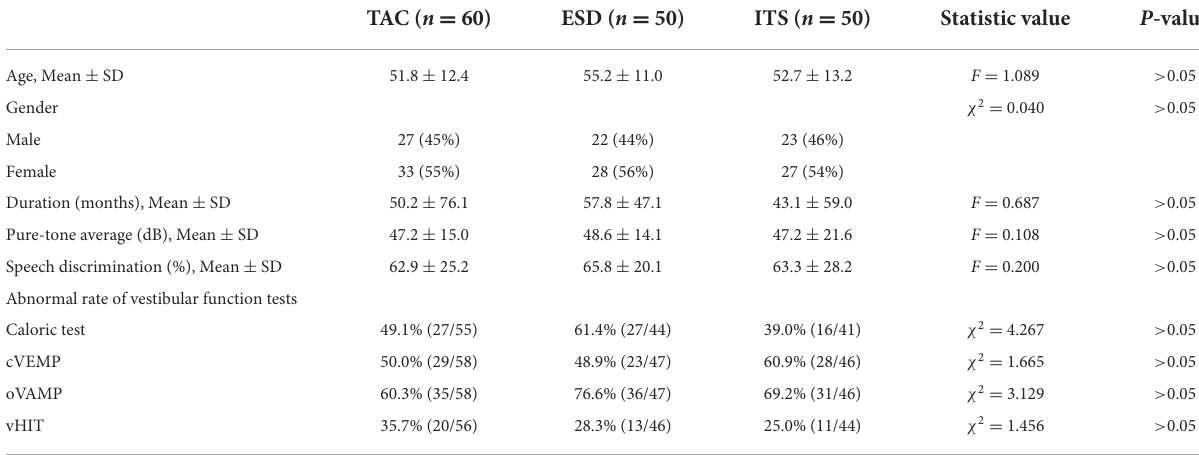
TABLE 1 Demographics and baseline